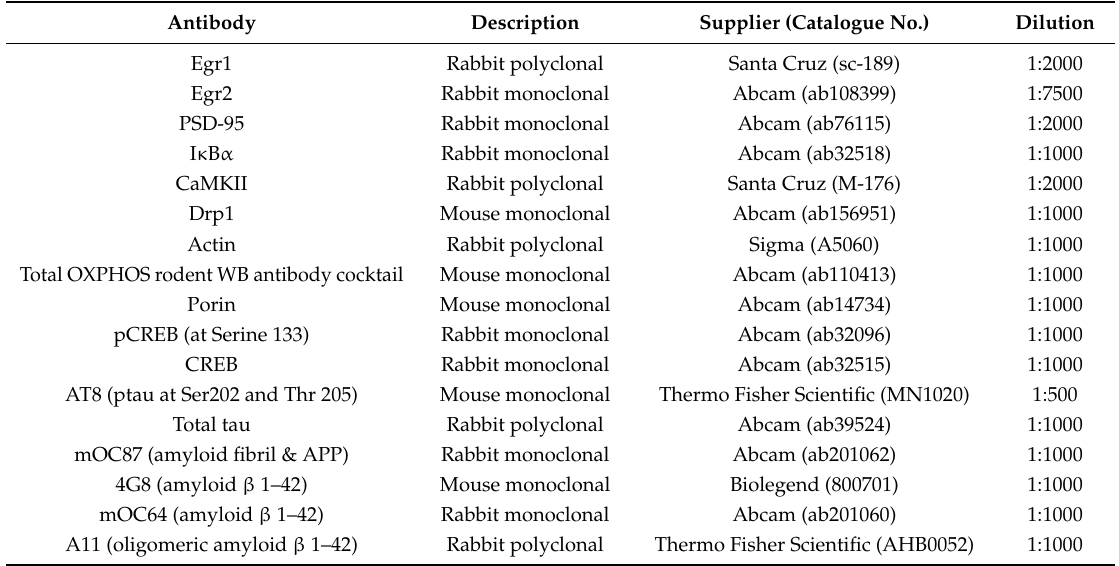
Table 1. Primary antibodies used in Western blot experiments in 3xTg